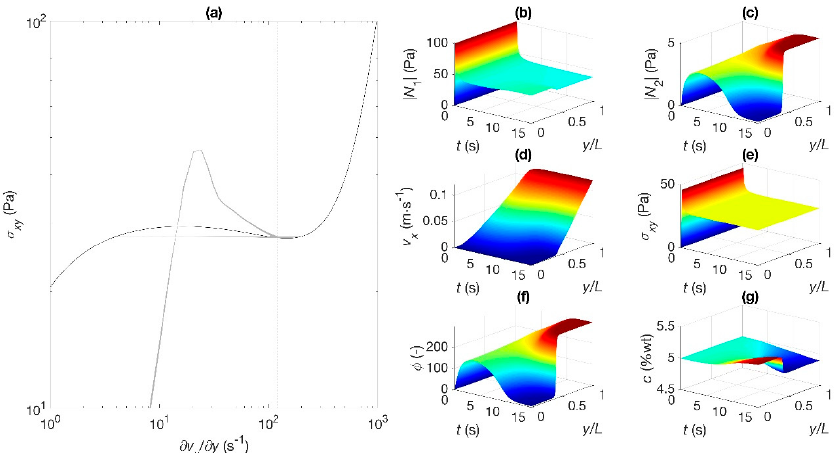
Figure 5. Dynamics and steady state under controlled shear rate. Reference shear rate is 120 s − 1 . Temporal trajectory of the stress and shear rate for various spatial positions ( a ), evolution of the normal stress differences N 1 ( b ) and N 2 ( c ), velocity ( d ), shear stress ( e ), fluidity ( f ), and concentration ( g ), in space and time.